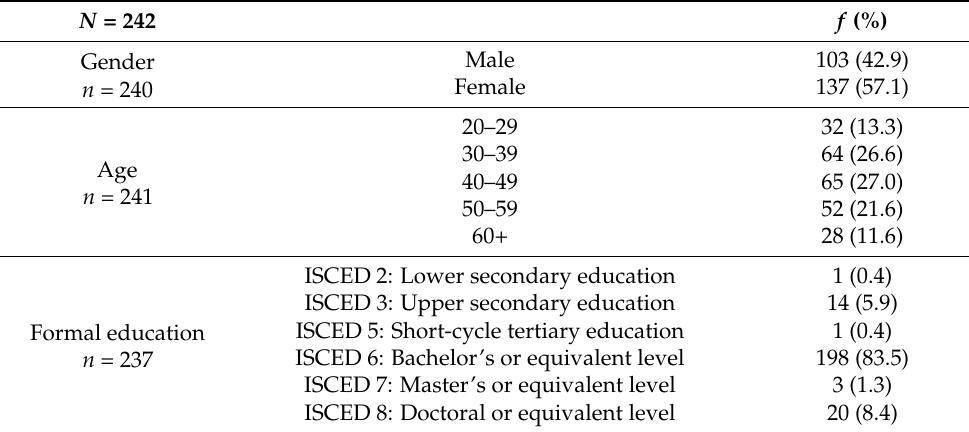
Table 1. Socio-demographic characterization of the surveyed population.